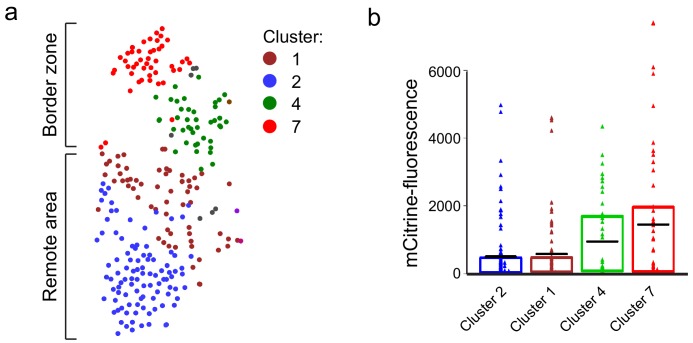
Cluster 7 cells display highest nppa:mCitrine expression.(a) tSNE map of the cardiomyocyte clusters derived from the single-cell mRNA-sequencing. (b) mCitrine fluorescence levels of the nppa:mCitrine FACS sorted cells from injured hearts that were used for the single-cell RNA-sequencing. Triangles represent individual cells of the four cardiomyocyte clusters. The box indicates the 25–75% quartiles, black lines indicate mean-fluorescence per cluster.